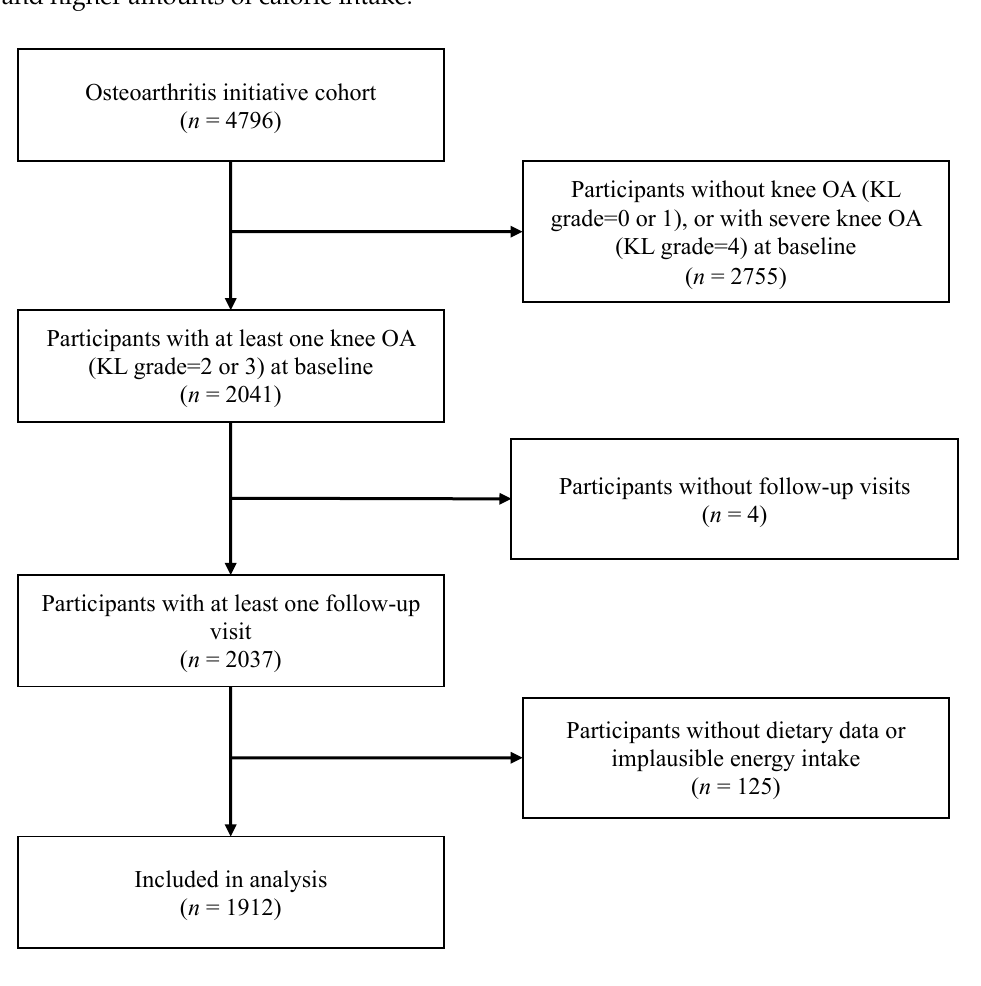
Figure 1. Flowchart of screening-eligible subjects. OA = osteoarthritis; KL grade = Kellgren–Lawrence grade.